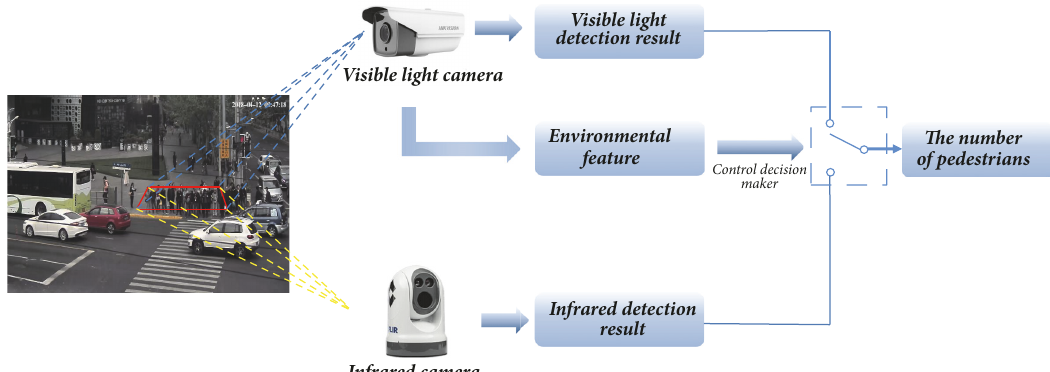
Figure 1: Pedestrian-counting